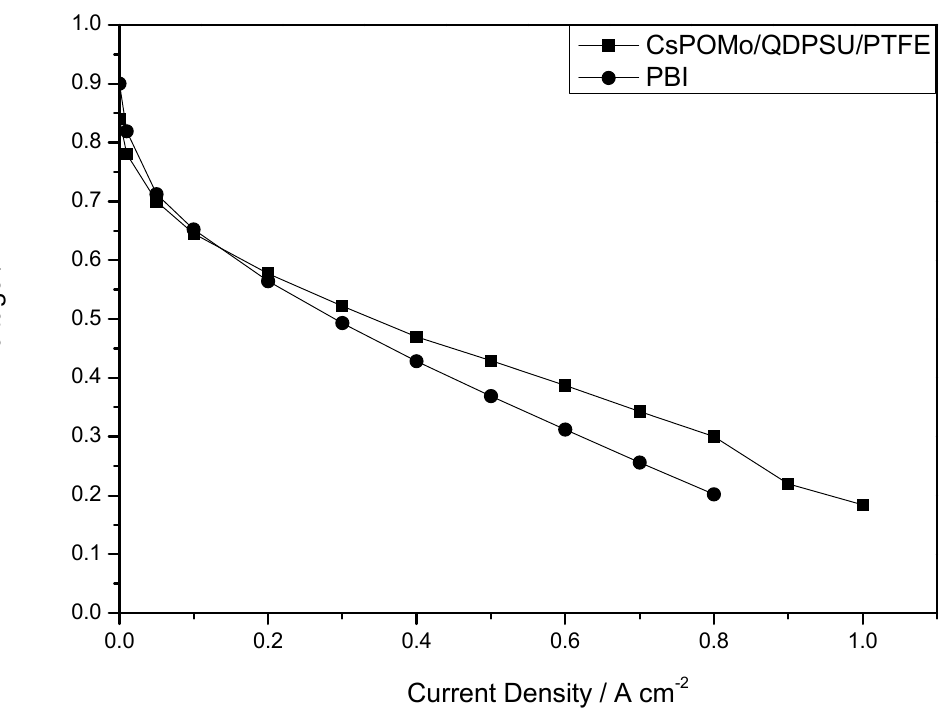
Figure 6. Polarization curves of CsPOMo/QDPSU/PTFE and PBI fuel cell operated at 150 °C with H /O . Atmospheric pressure, no gas 2 2